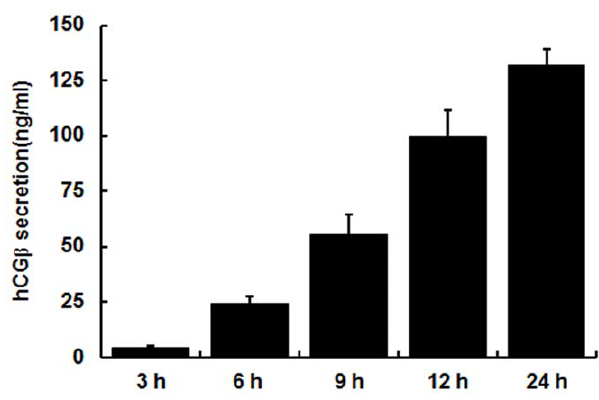
Figure 2. HCG detection in the culture medium via ELISA. Data showed that there was hCG b secreted into cell medium. Furthermore, the level of hCG b secreted into medium increased with time after the hCG b transfected cells were incubated for 3, 6, 9, 12 and 24